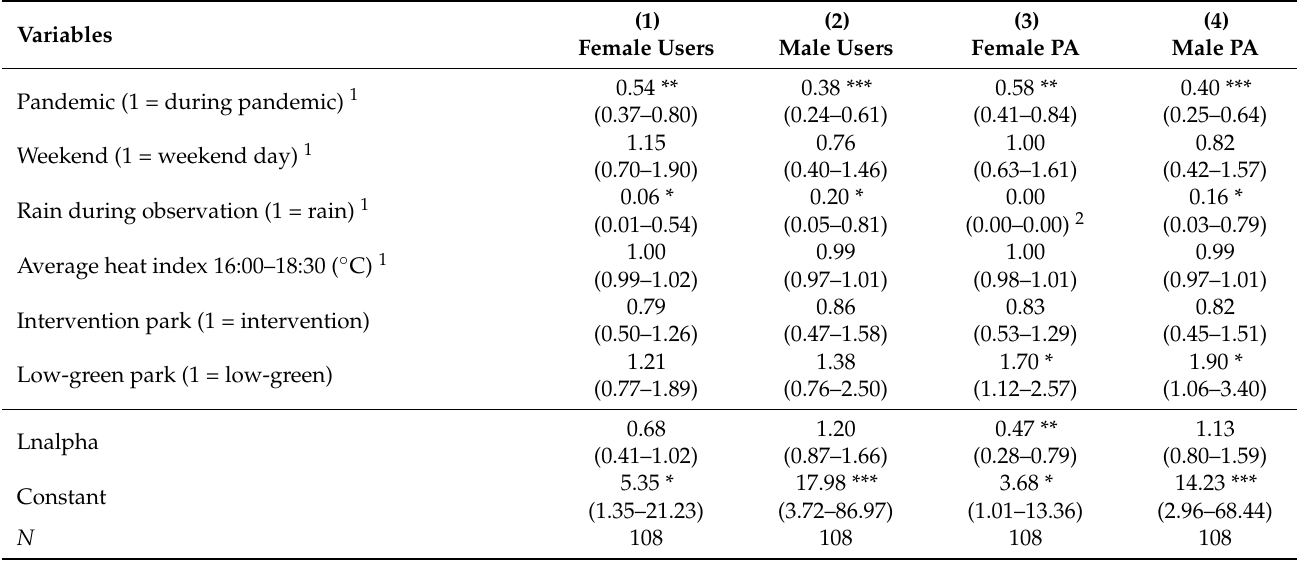
Table 2. Model output for relations between COVID-19 pandemic and use of joint-use parks by children outside of school